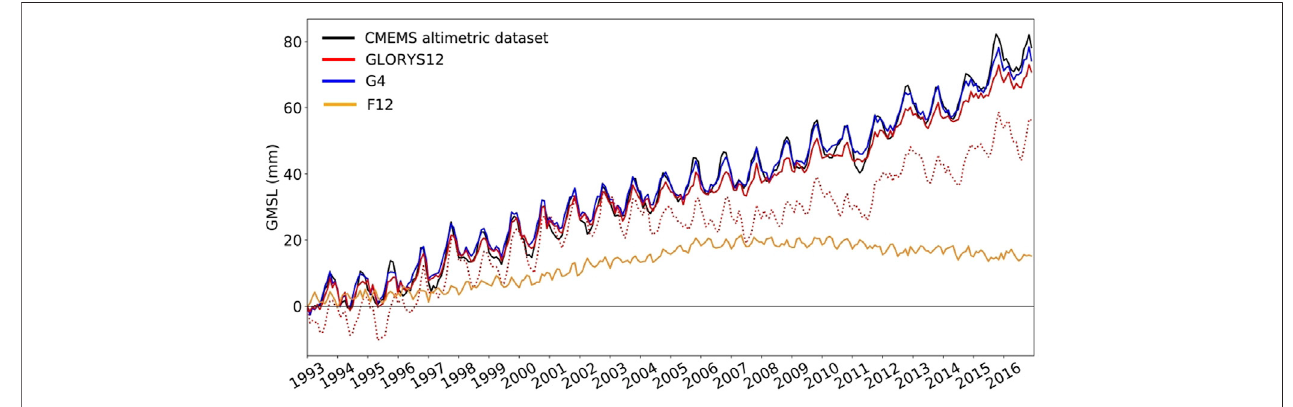
FIGURE 14 | Global mean sea level monthly time series for the CMEMS gridded reprocessed altimetric dataset (007_048, in black), GLORYS12 (in red), F12 (in orange) and G4 (in blue). The global mean steric sea level of GLORYS12 is also shown (dashed red line). The same ocean mask has been used when computing the global mean. Only points with valid monthly means in altimetric sea level data along the whole 1993 – 2016 period have been used in the global mean.